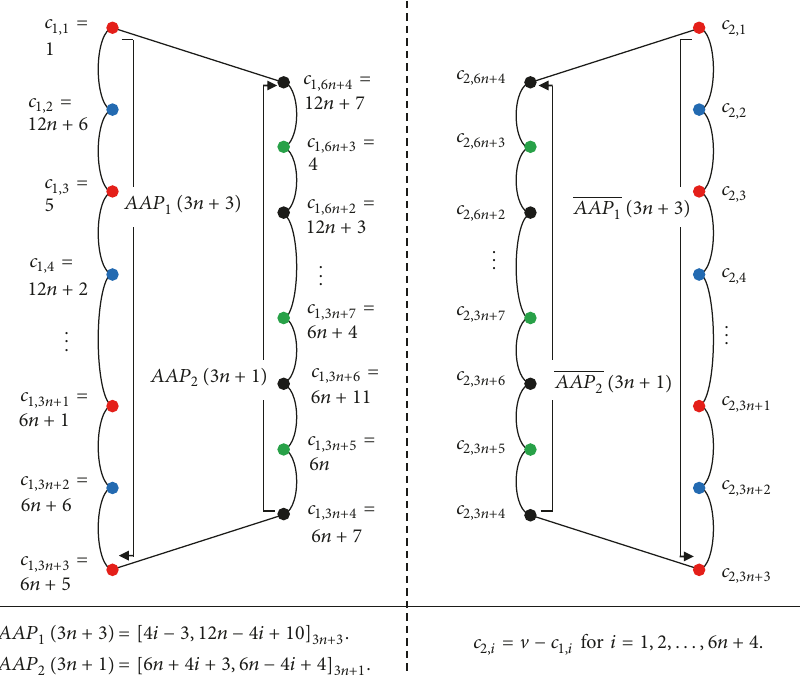
Figure 2: The construction of 𝐶 1 and 𝐶 2 in 2𝐾 V , 𝑛 is a nonnegative even